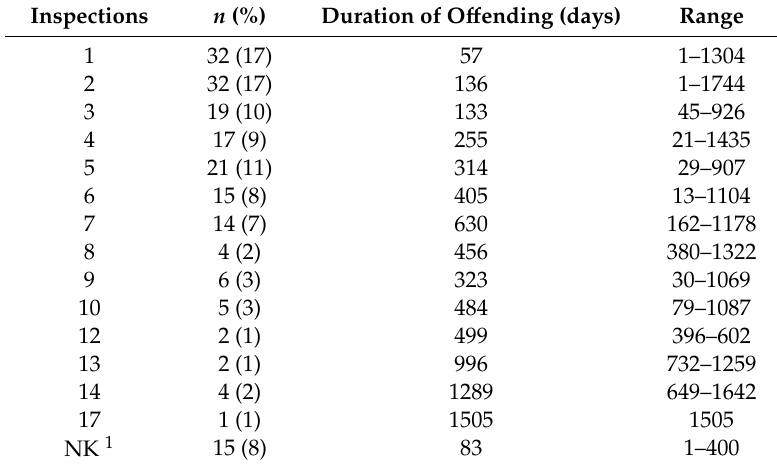
Table 1. The number of animal welfare inspections used as a base for prosecution and median duration of an o ff ending confirmed by a court in animal welfare cases ( N = 189) heard in Finnish district courts during